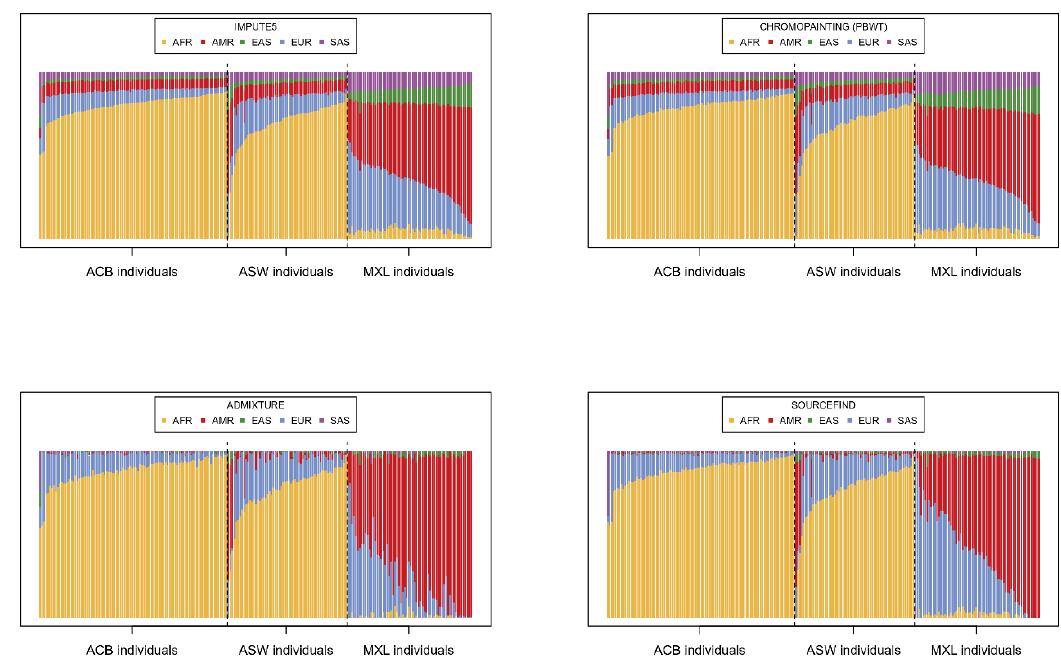
Figure 2. In these plots, each of the 221 target individuals has a vertical bar, which is coloured depending on the proportion of their genome assigned to the different super-populations from the reference panel. The individuals are in the same order across the plots, arranged according to the proportions in the top left plot. Top left: Proportions of the genome (autosomal chromosomes) imputed with haplotypes from the 5 super-populations AFR, EUR, EAS, SAS, and AMR, as ascertained by cumulating the dosages of the imputation barcodes. Top right: Proportions are estimated from the total ‘chunk length’ matrix derived from the chromo-painting algorithm of software pbwt. Bottom left: Ancestry proportions assigned by applying ADMIXTURE (supervised mode). Bottom right: Proportions assigned by SOURCEFIND.